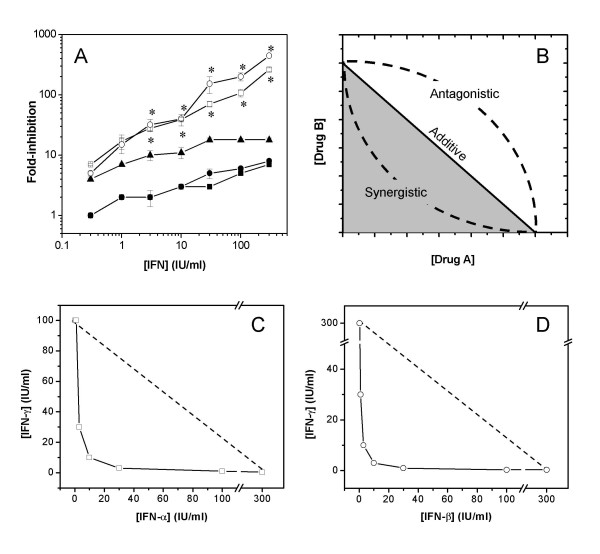
Type I IFNs (IFN-α and IFN-β) and type II IFN (IFN-γ) synergistically inhibit HCMV plaque formation on HFFs. (A) Viral plaque reduction assay. HFFs were treated with vehicle or increasing amounts of IFN-α (■), IFN-β (●), IFN-γ (▲), IFN-α and IFN-γ (□) or IFN-β and IFN-γ (○) prior to infection with 400 PFU of Towne-GFP (n = 3). Fold-inhibition in IFN-treated groups as compared to vehicle-treated groups is plotted as a function of IFN concentration (IU/ml). Significant differences in fold-inhibition for HFFs treated with combination IFNs relative to cells treated with individual IFNs are denoted by a single asterisk (P < 0.001, one-way ANOVA and Tukey's post hoc t test). (B) Illustration of a representative isobologram for a combination of two drugs. The solid line is the line of additivity. When the isobole lies below the line of additivity, the combinatorial effect of drug A and drug B is synergistic. When the isobole lies above the line of additivity, the combinatorial effect of drug A and drug B is antagonistic. Combination effect of (C) IFN-α and IFN-γ and (D) IFN-β and IFN-γ on HCMV plaque formation on HFFs was plotted in an isobologram. Values used to generate the concave isoboles were derived from a dose response curve and represent a combination dose required to elicit 95% (IC95) inhibition of viral plaque formation on HFFs. The dashed line represents the theoretical line of additivity.